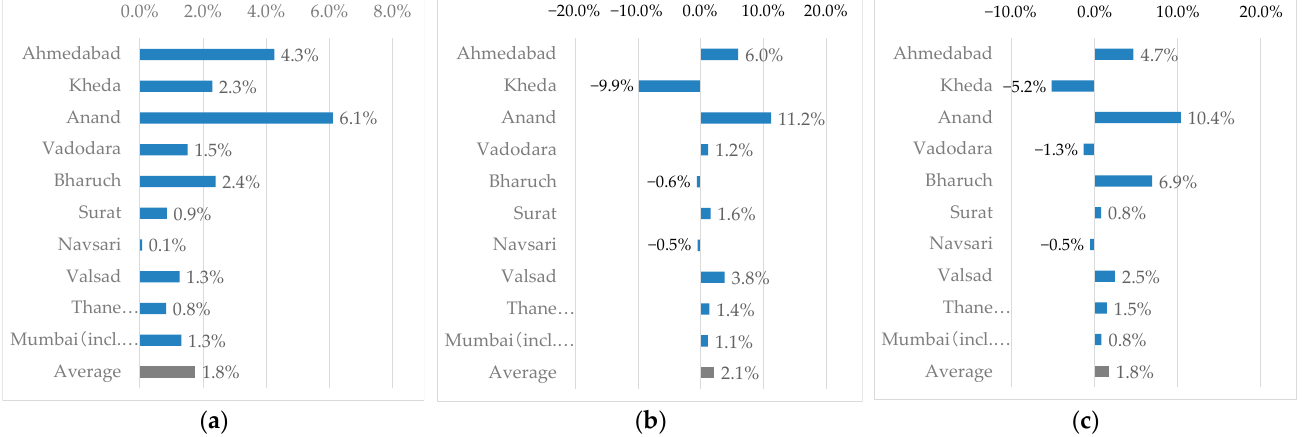
Figure 5. Estimated increase in annual GRP by zone: ( a ) all industries and services; ( b ) commerce; ( c ) other services.